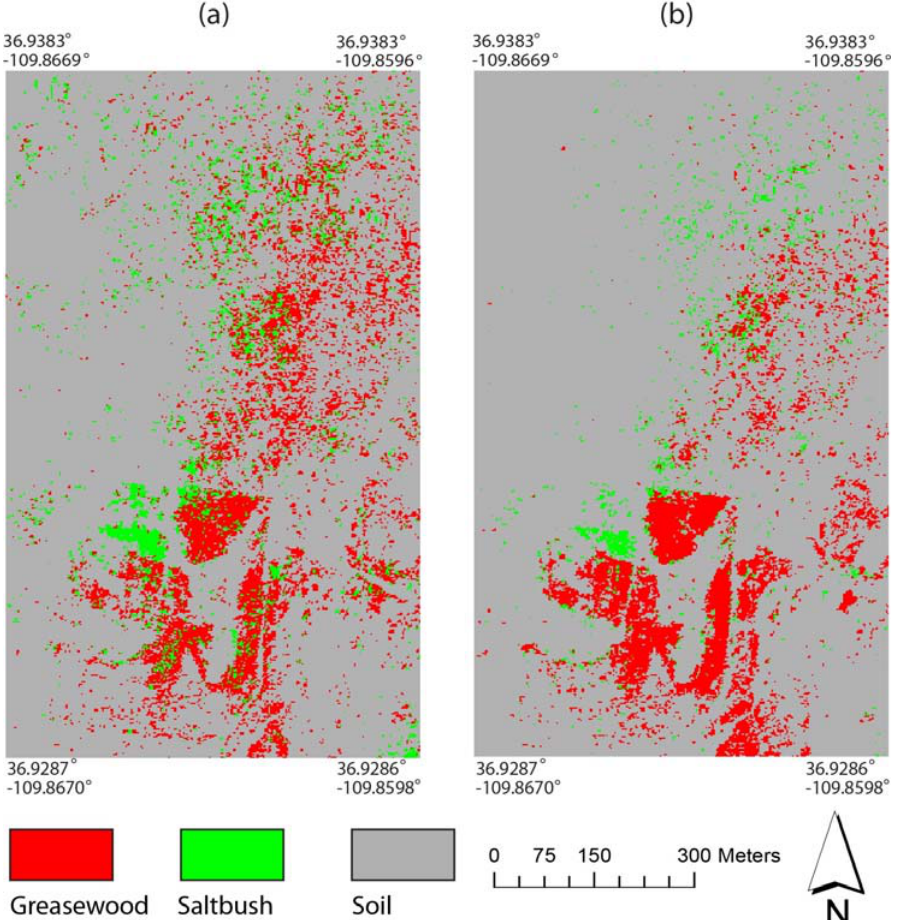
Figure 11. The vegetation species distribution maps for the Monument Valley site based on the decision trees ( a ) using the MTMF-derived metrics and vegetation indices, and ( b ) using the original scaled reflectance